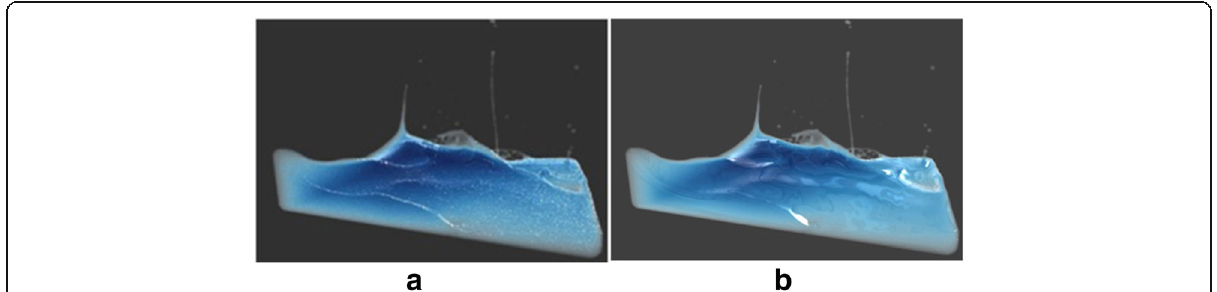
Fig. 2 The smoothed image by our filter. a Before smoothing. b After